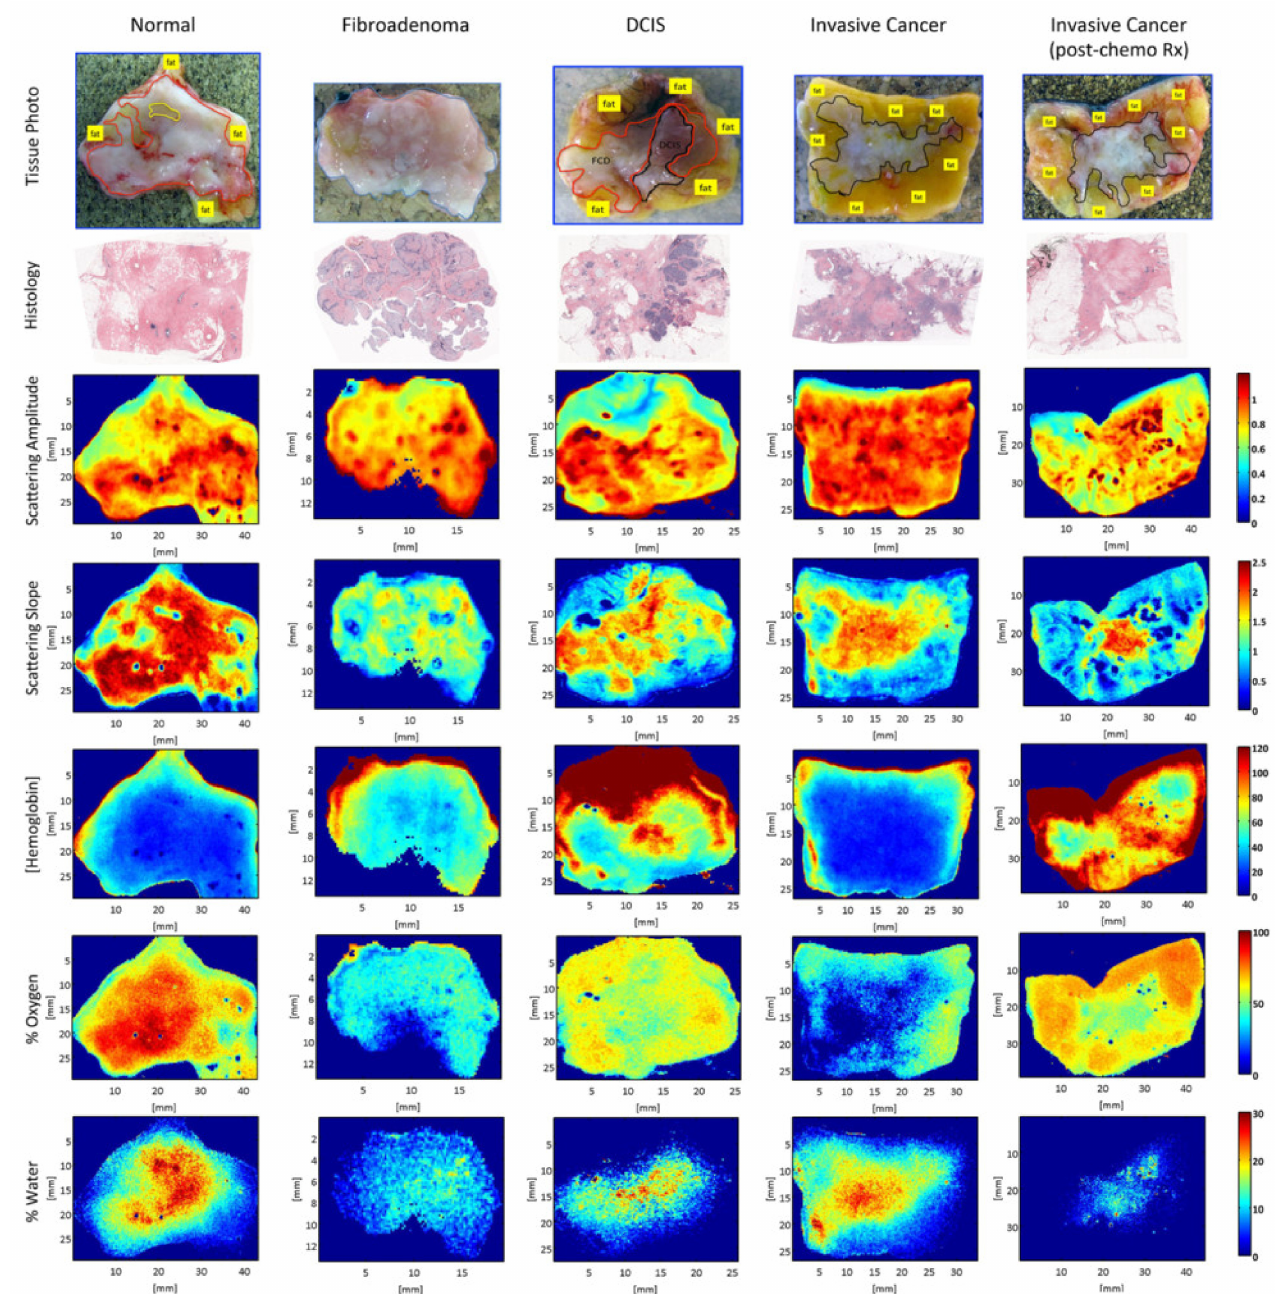
Figure 5. Representative spectral parameter maps for tissue subtypes. Spectral parameter maps correspond to the pathology subtypes: normal (including fibrocystic disease) (red outline), fibroadenoma (blue outline), DCIS, invasive cancer and partially treated invasive cancer after neoadjuvant chemotherapy (all black outline), and fat (yellow outline or label). Row 1 is the tissue photograph of the cut face of one slice of the specimen with the lesion; row 2 is the corresponding histology; row 3 is the scattering-amplitude maps; row 4 is the scattering slope maps; row 5 is the hemoglobin concentration maps; row 6 is the percentage oxygenated hemoglobin maps; and row 7 is the percentage water maps (adapted from Ref.